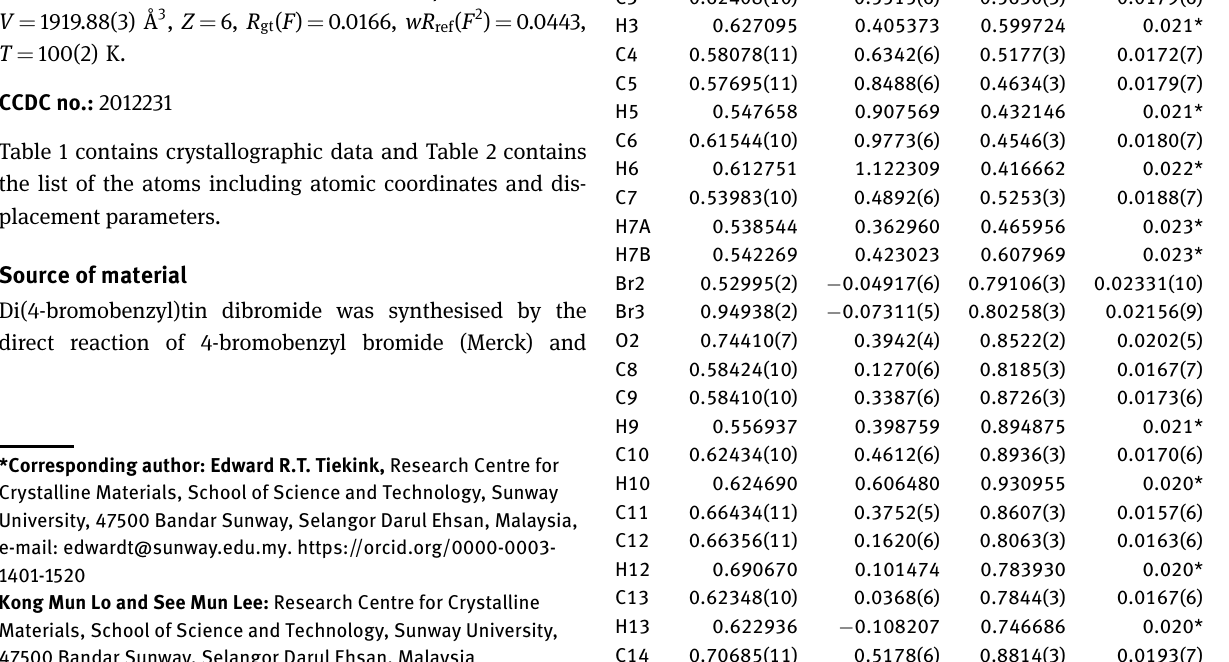
Table 1 contains crystallographic data and Table 2 contains the list of the atoms including atomic coordinates and dis- placement parameters.